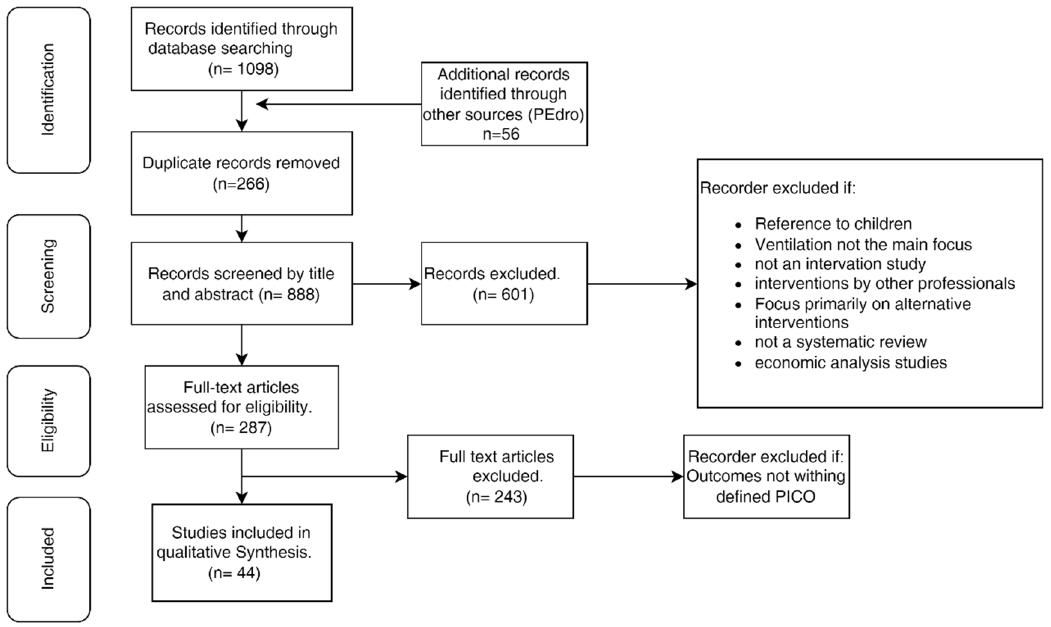
Figure 1. Flowchart of the study selection and inclusion process. Assessment of methodological